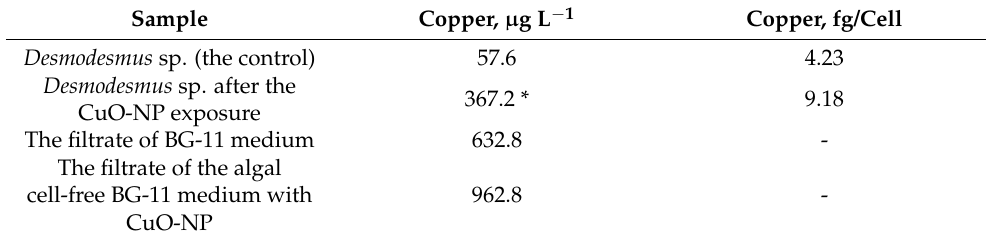
Table 1. Copper content in different sample